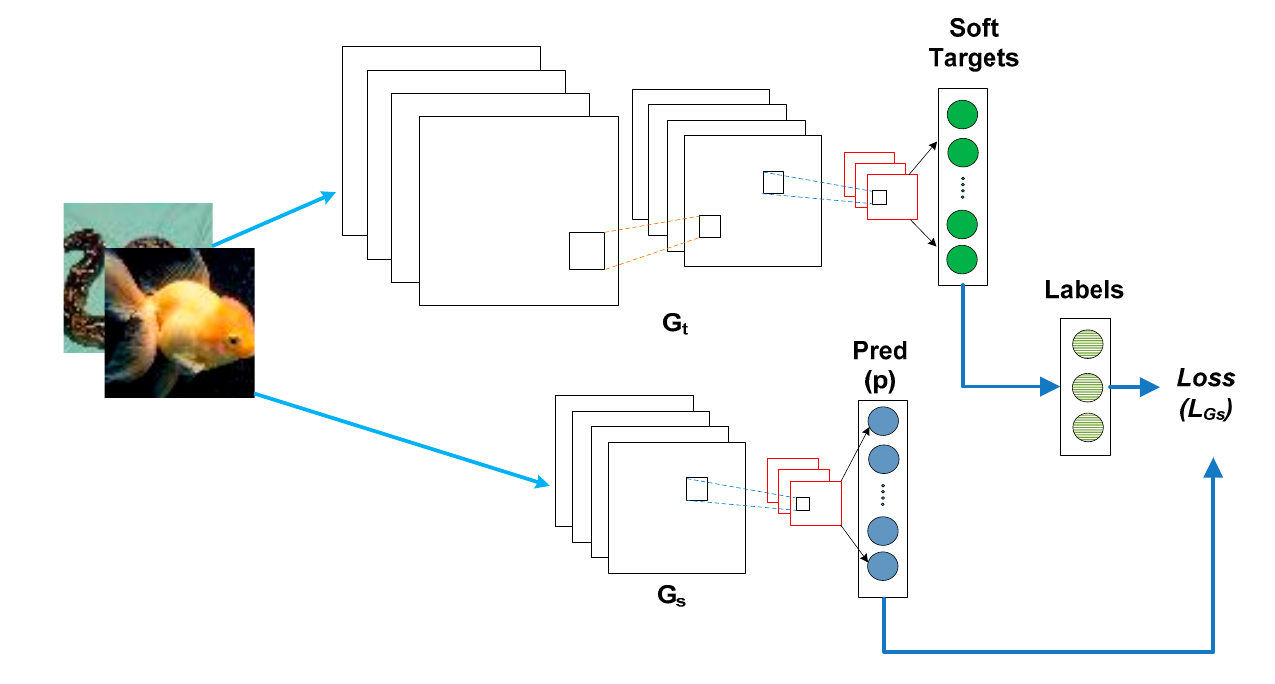
Figure 2. Training teacher–student framework using knowledge distillation (KD).